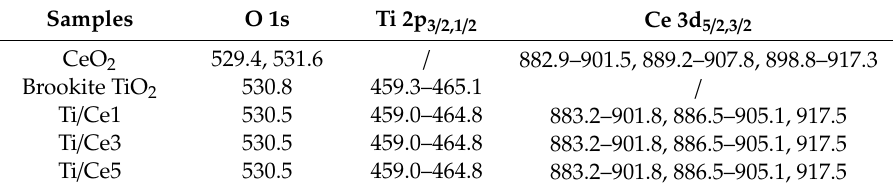
Figure 6. ( a ) Al K α -excited XPS of the Ti / Ce5 composite obtained in the Ti 2p zone; ( b ) in the O 1s binding energy region and ( c ) in the Ce 3d binding energy region. Structure due to the satellite radiation was subtracted from the spectra. Table 2. Binding energies (eV) obtained by XPS for the analyzed materials.